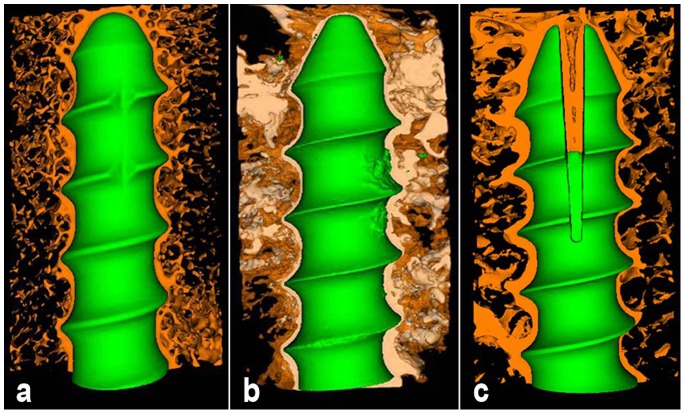
Three-dimension micro-CT reconstruction of interface between bone and screw in three groups at 6-week.“a”, “b” and “c” indicate CPS group, PMMA-PS group and EPS group, respectively. Brown color, blue color and white color represent bone tissue, screw and PMMA, respectively. (Resolution 21 µm, 2048×2048).